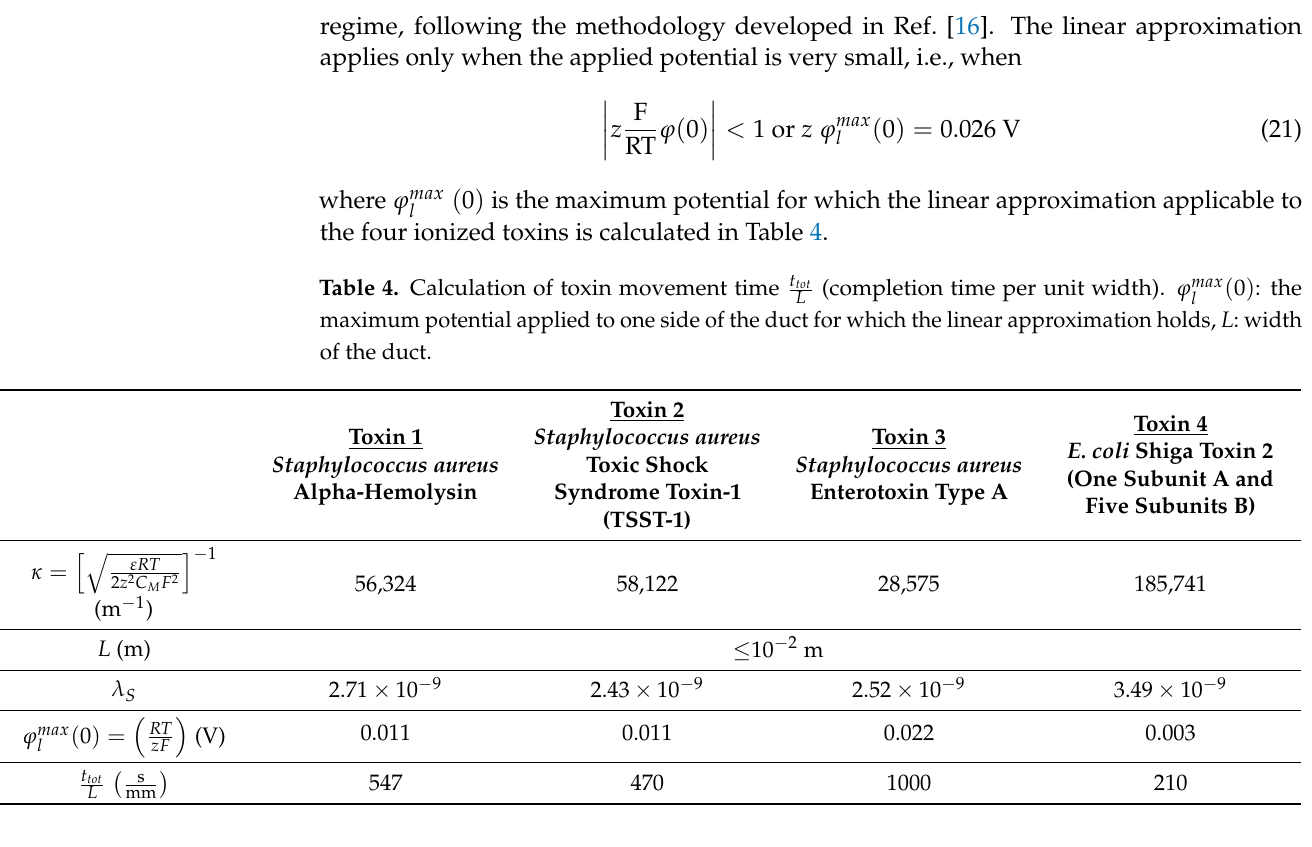
(completion time per unit width). ϕ max L